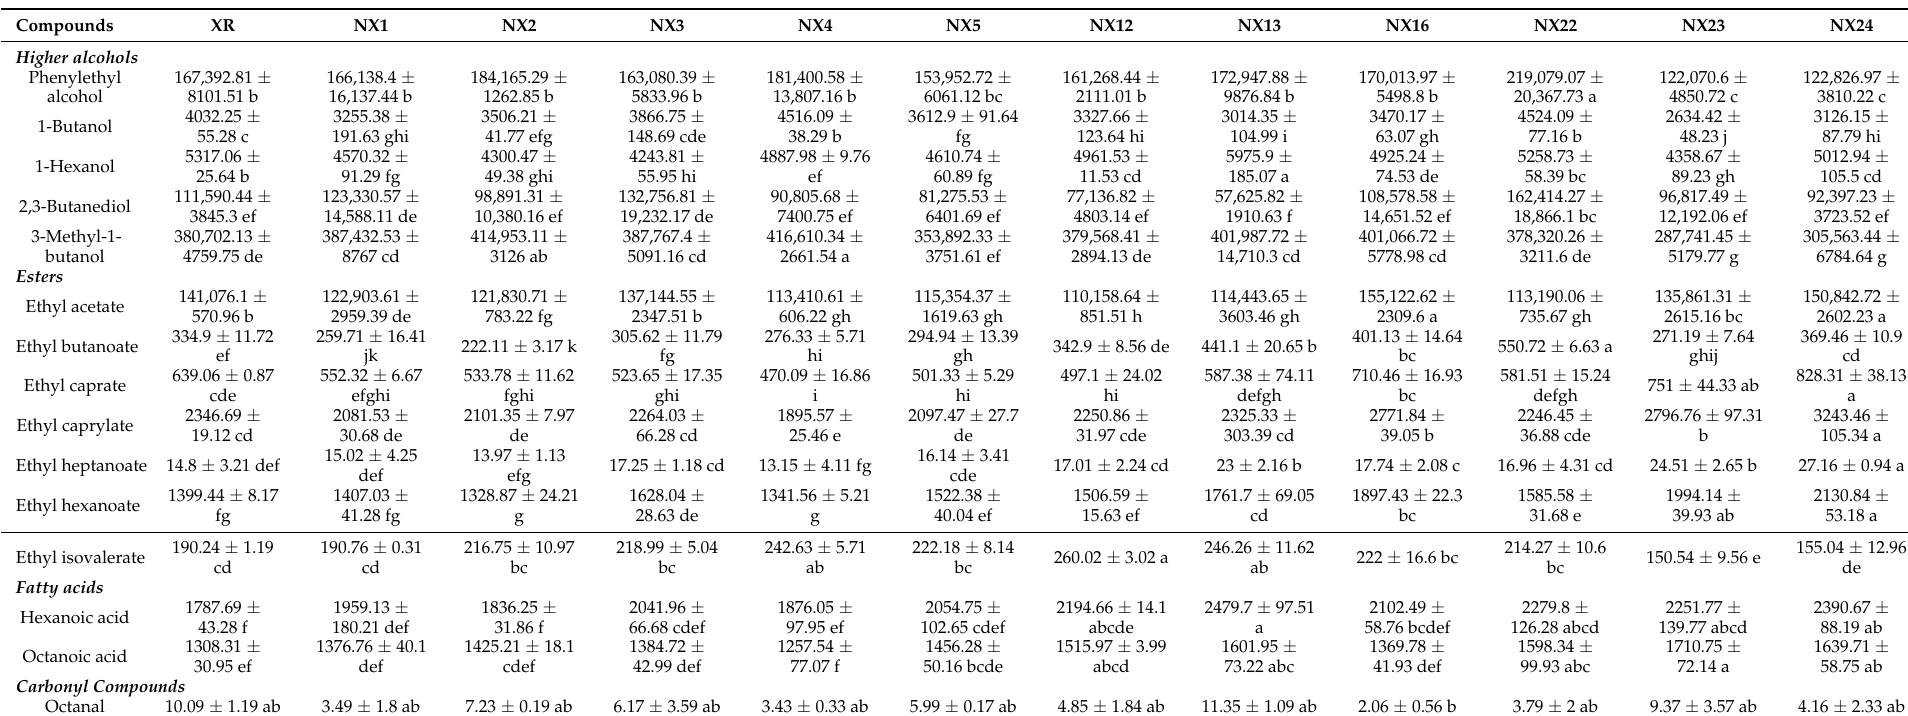
Table 2. Concentrations ( µ g/L) of volatile compounds with OAV > 1 in Cabernet Sauvignon wines fermented by the indigenous S. cerevisiae strains and the commercial strain